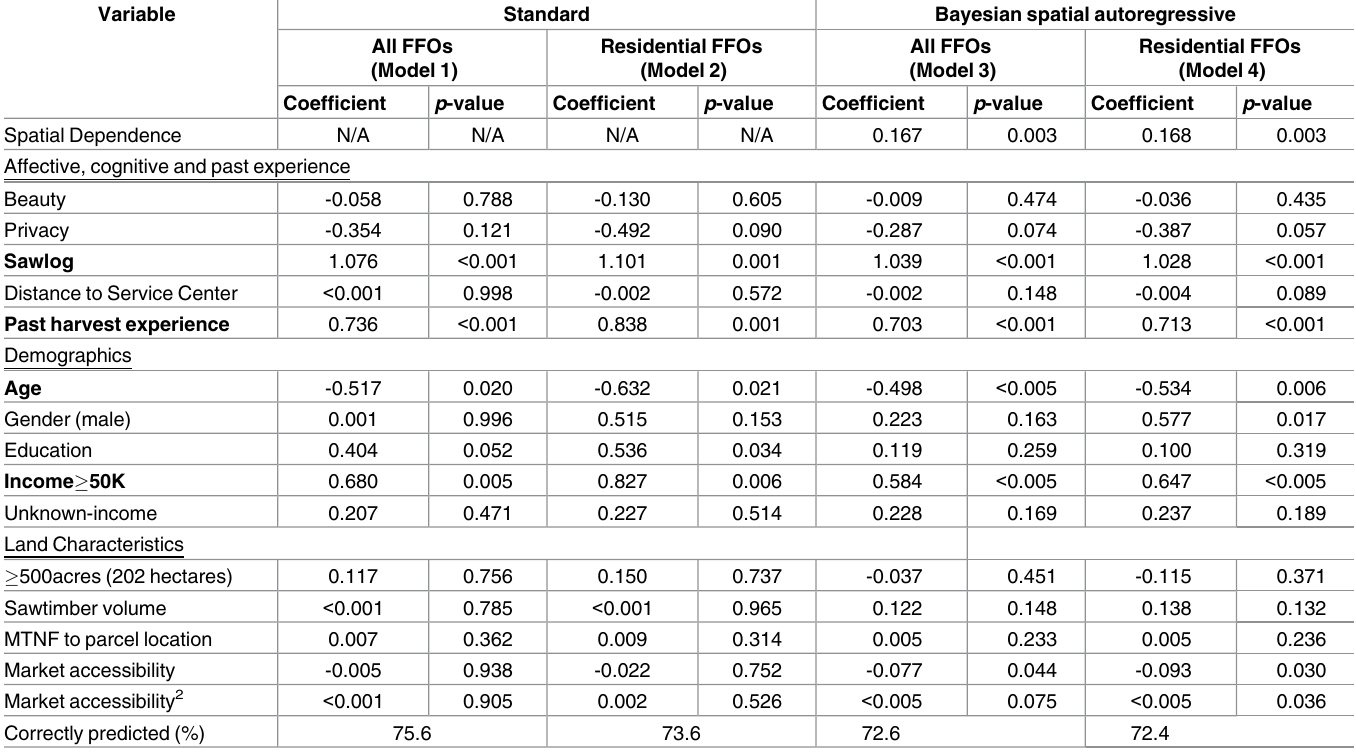
Table 2. Results of Standard and Bayesianspatial autoregressive probit